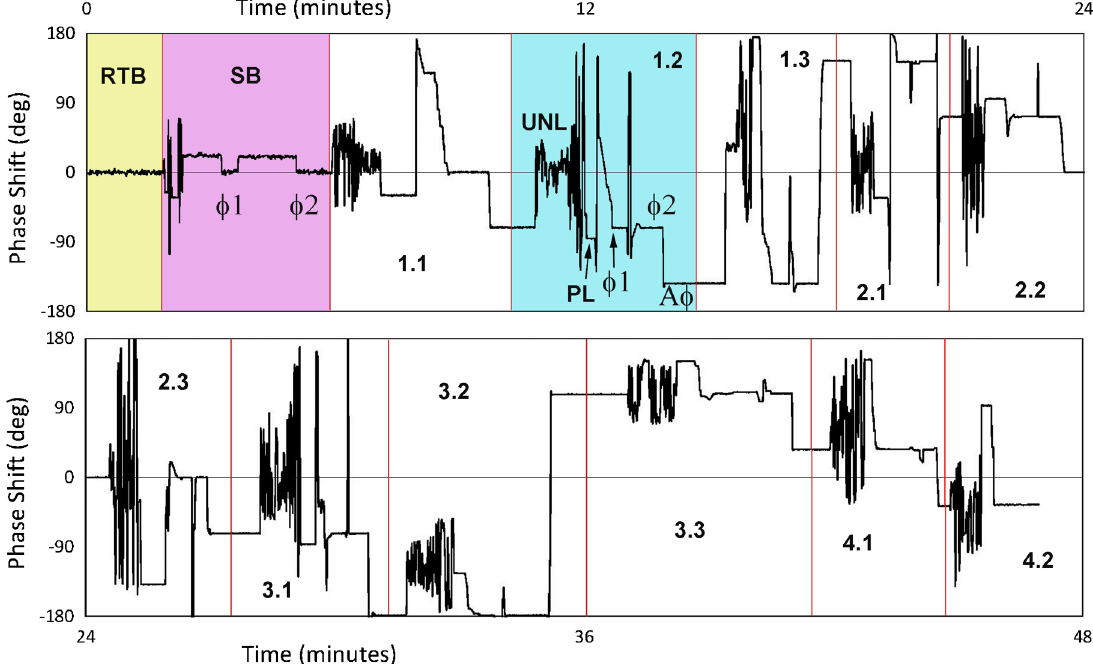
FIG. 9. Phase shift of the bunch phase measured with superconducting SLR 4.3 with respect to the master oscillator as a function of time. Each segment signifies the operation condition of the rf resonators. 1.1 stands for the first SLR in the first module cryostat, etc. RTB (yellow area) stands for room temperature buncher and SB (pink area) for super buncher. Examples of typical operating conditions of resonator 1.2: UNL- operation SEL in unlocked mode; PL- phase locked condition; ϕ 1 , ϕ 2 , and A ϕ are two crossovers and acceleration phase